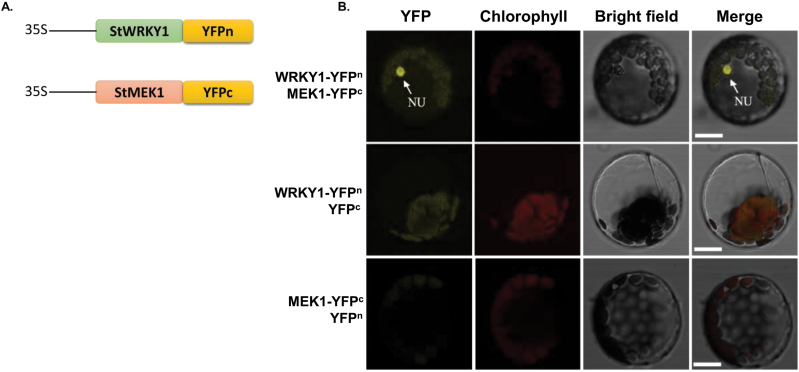
BiFC assay for StWRKY1 and StMEK1 interaction: (A) constructs used in the BiFC expression assay, and (B) BiFC assay showing the interaction between StWRKY1-YFPc and YFPn-StMEK1. The nucleus (NU) is shown in yellow and chlorophyll autofluorescence is shown in red. Bars, 5mm. (This figure is available in colour at JXB online.)